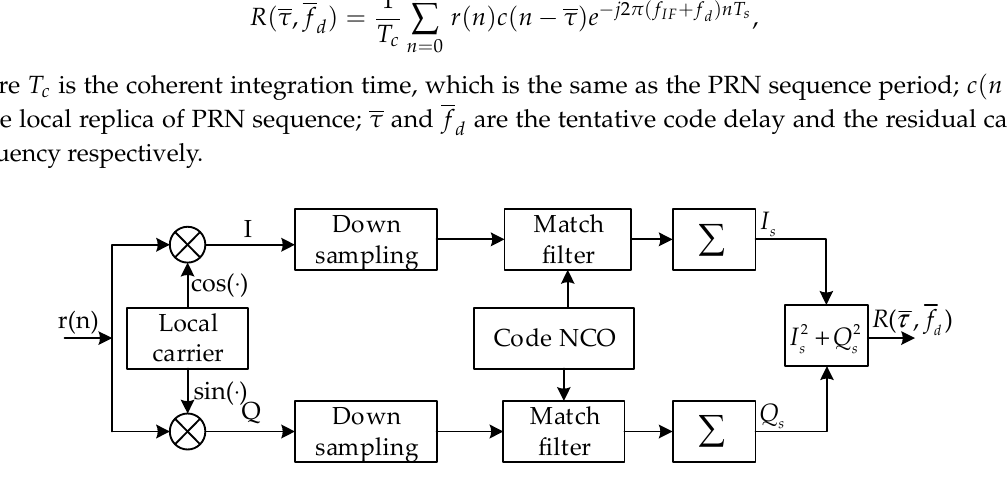
Figure 7. Flowchart of the matched filter method.